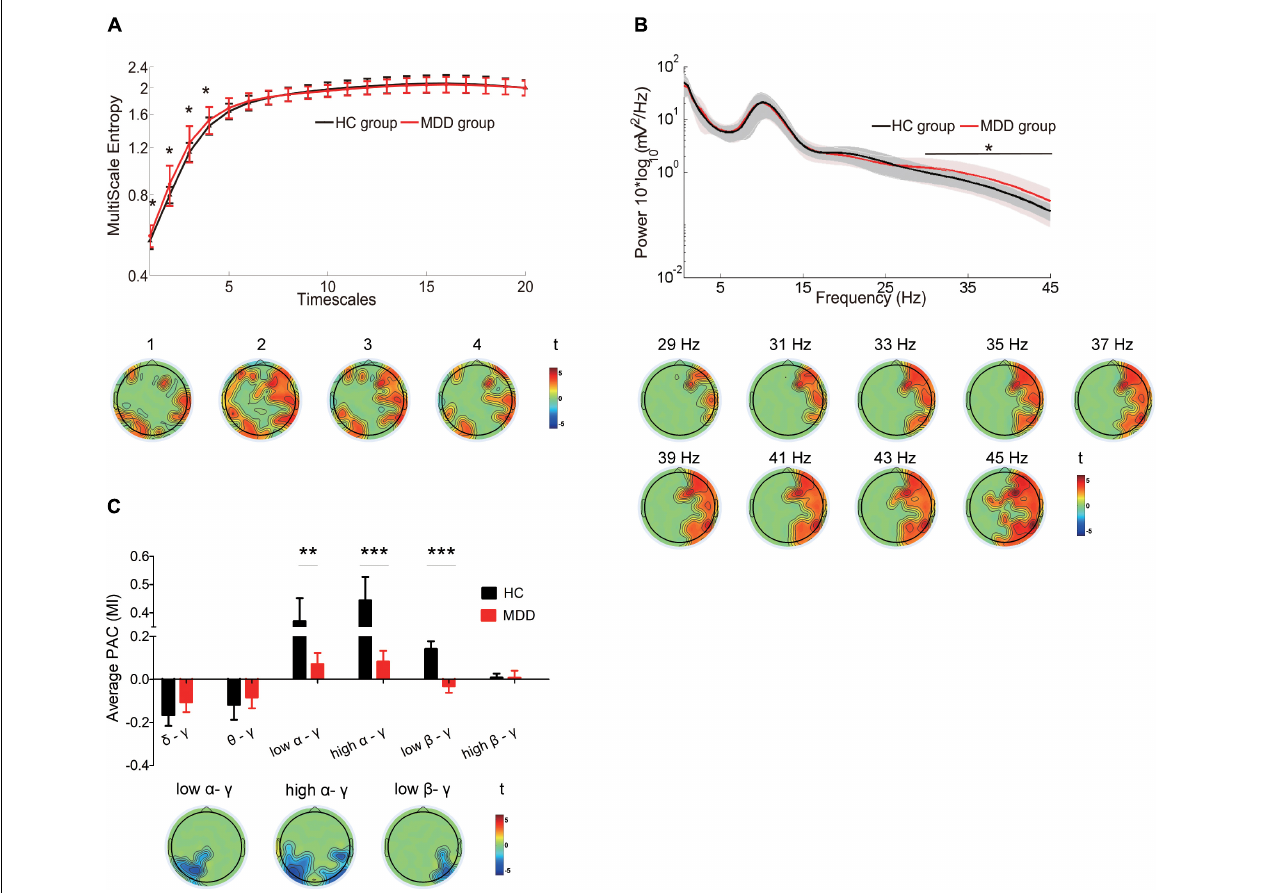
FIGURE 1 | Differences in the complexity of temporal dynamics and oscillations in the MDD group compared with the complexity of temporal dynamics and oscillations of the HC group (A) Top: Waveforms depict MSE (y-axes) across all electrodes for timescales 1–20 (x-axes) in HCs (black line) and MDD patients (red line). Bottom: Topographic distribution of statistical significance in MSE in the MDD group compared with the HC group. Each topography reflects the significant t-maps following correction for multiple comparisons, depicting only the significant clusters with P < 0.05 and setting non-significant pixels to 0. Topographies highlight the spatial characteristics of the increase in MSE at fine timescales < 5 (cluster P = 0.038). (B) Top: Waveforms depict the average absolute power (y-axes) across all electrodes from 0.5 to 45 Hz (x-axes) in HCs (black line) and MDD patients (red line). Bottom: Topographic distribution of statistical significance in power in the two groups. Topographies highlight the spatial characteristics of the increase in power from 29 to 45 Hz (cluster P = 0.034, presented with a step of 2 Hz). (C) Top: Box plots depict the strength of low-frequency phase and gamma amplitude coupling in HCs (black) and MDD patients (red). The Y-axis represents the mean of the modulation index (MI) across all the electrodes. Bottom: Topographic distribution of statistical significance in PAC in the two groups. Topographies highlight the spatial characteristics of the reduction in low alpha/gamma (cluster P = 0.021), high alpha/gamma (cluster P = 0.004) and low beta/gamma (cluster P = 0.0017) PAC. Data were presented as mean ± SEM. Asterisks indicate significant group differences: * P < 0.05, ** P < 0.01, *** P <